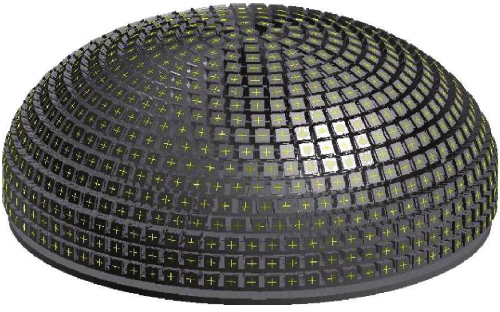
Figure 2: Hemi-spherical array.